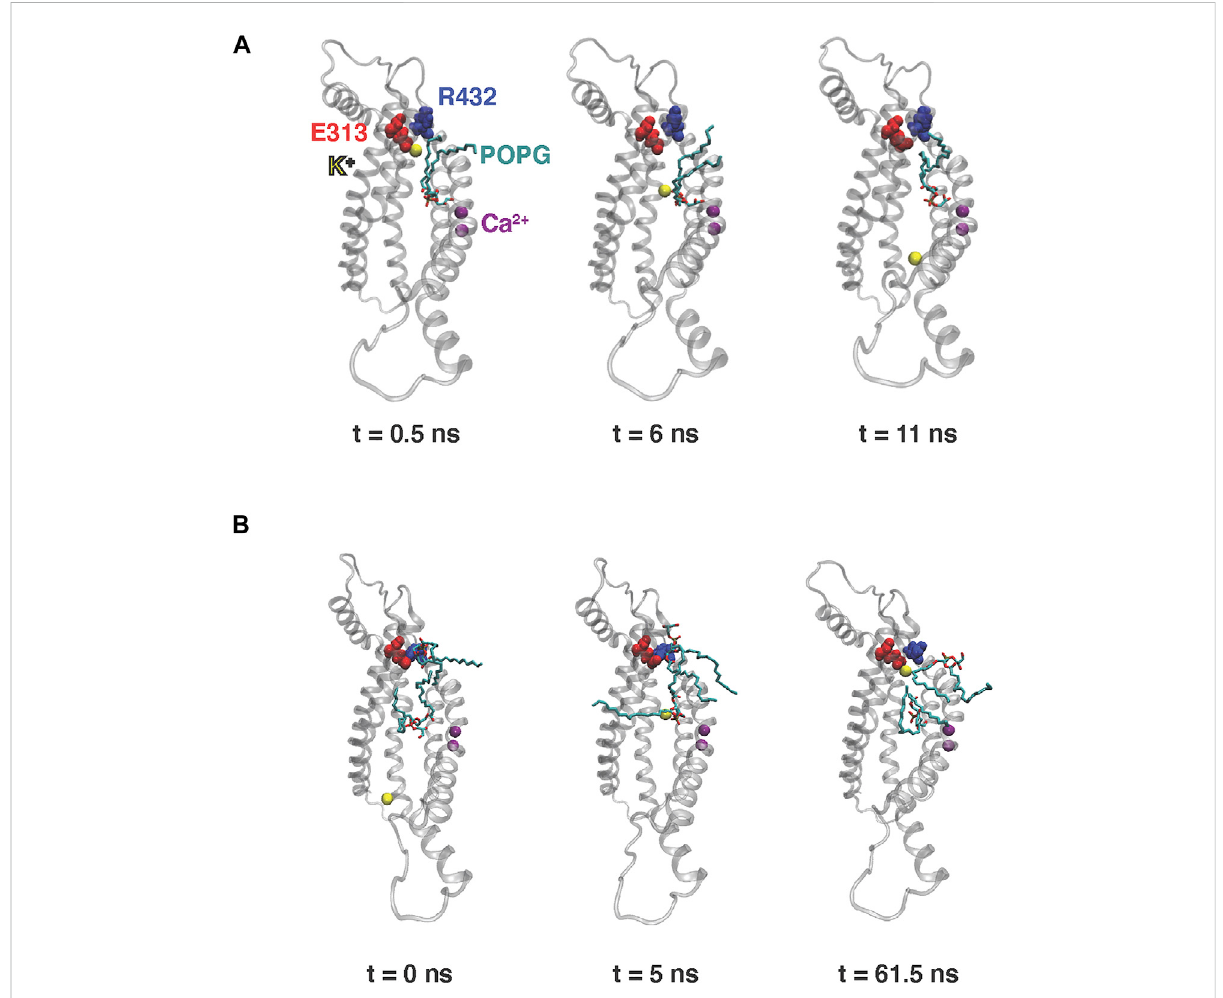
FIGURE 2 Snapshots from the 10 µs MD simulation of nhTMEM16 capturing the potassium ion permeation events in Supplementary Movies S1, S2. Time zero in the fi gure corresponds to the beginning of each described translocation processes occurring at 5.8 and 7 μ s, respectively (see also Figures 3A,Bbelow) (A) PermeationfromECtoIC. (B) PermeationfromICtoEC.NotethatfortheEC-to-ICtranslocationprocess (A) weshowthe fi rstframe at t = 0.5 ns, as the ion is distant from the groove at t = 0 which is the starting frame for the Supplementary Movie S1. The potassium ion being translocated is shown as yellow sphere, POPG lipids are shown as licorice, TM3 – TM7 of nhTMEM16 are rendered in transparent cartoon, E313 is shown as red spheres, R432 is shown as blue spheres, and Ca 2+ ions are shown as purple